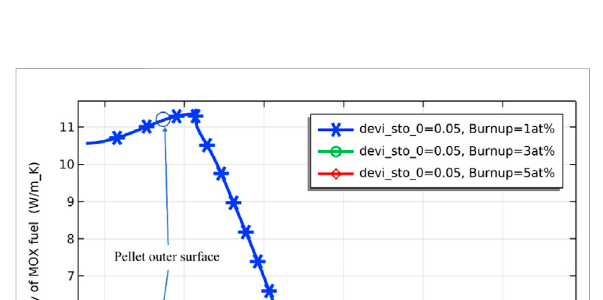
FIGURE 7 Fuel thermal conductivity against temperature for deviation from the stoichiometry of oxygen of 0.001, 0.01, 0.05 and 0.1 (burnup = 1 at%).